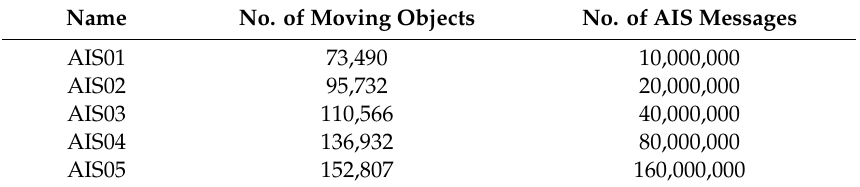
Table 3. Statistics of